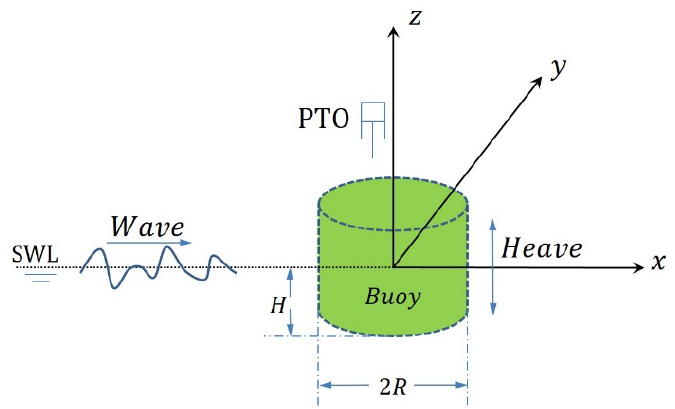
Figure 1. Schematic diagram of the WEC.